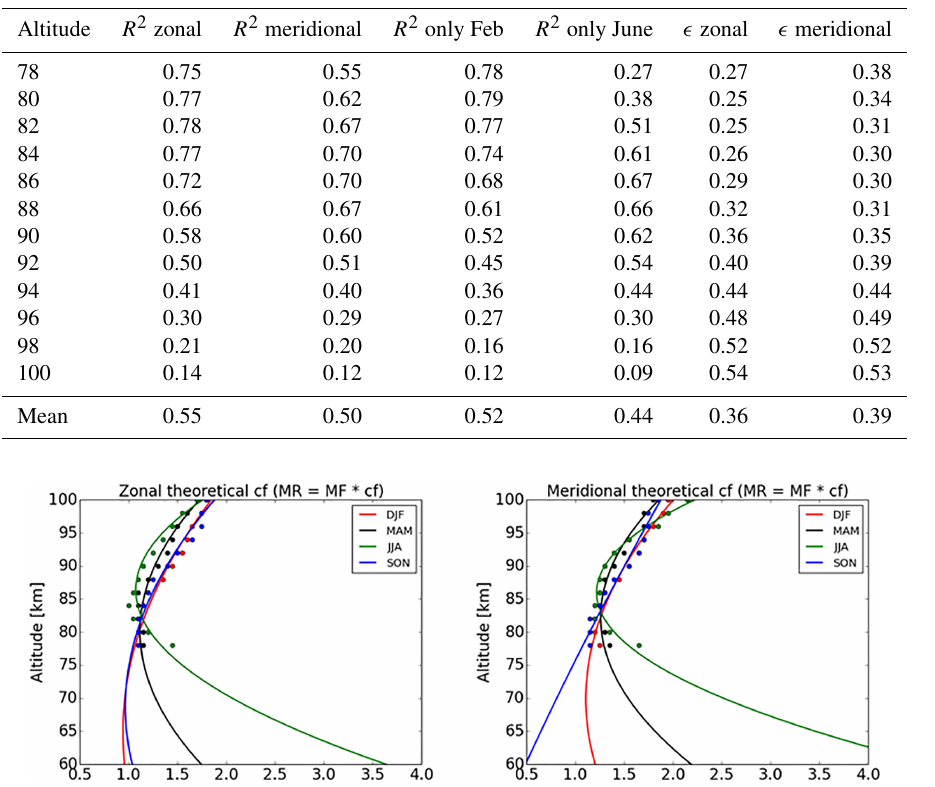
Table 2. Coefficient of determination for the altitudes 78 to 100km for the zonal and meridional wind component based on hourly wind values. February and June R 2 are for the zonal wind component, and (cid:15) describes the ratio between the length and the thickness of the scatter plot.